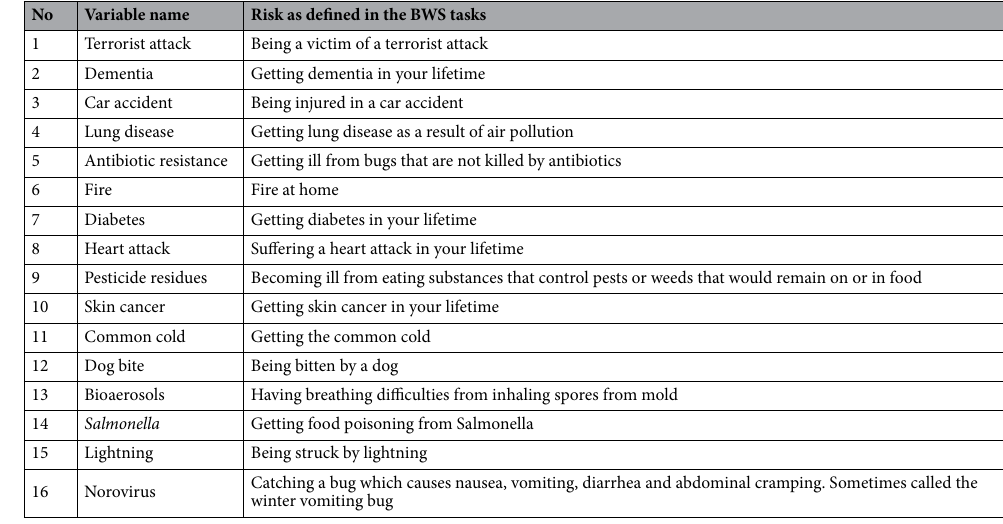
Table 2. Risks used in the best worst scaling (BWS).